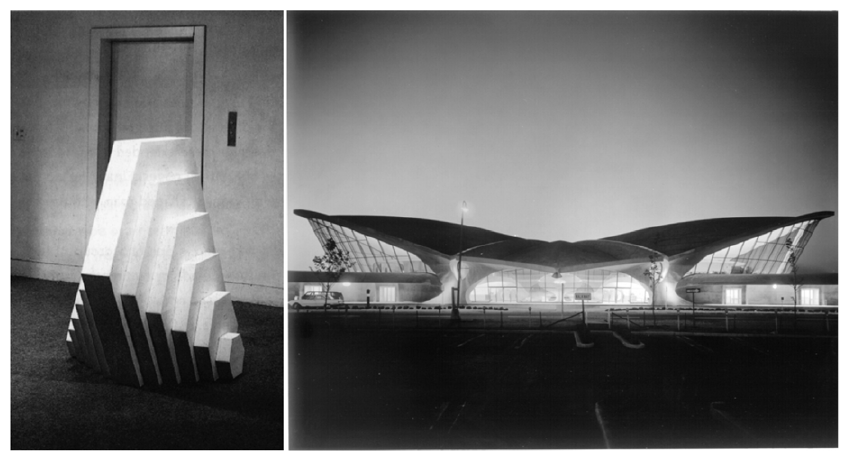
Figure 11. Robert Smithson, Terminal, 1966. This was the evolution of a 3d model of the DFW Terminal Building,